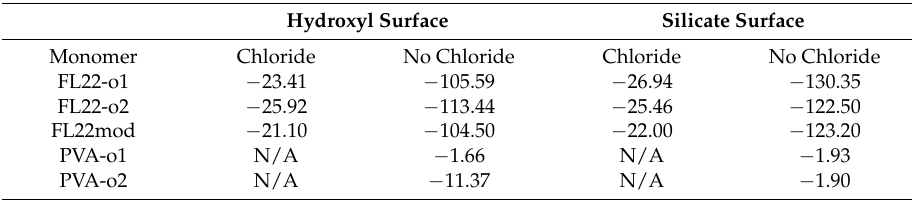
Table 5. Formation energies of the models, where ‘formation energy’ is as described in the main text. Units are kCal/mol. o1: Orientation 1 (OH-group pointing away from surface) and o2: orientation 2 (OH-group pointing towards